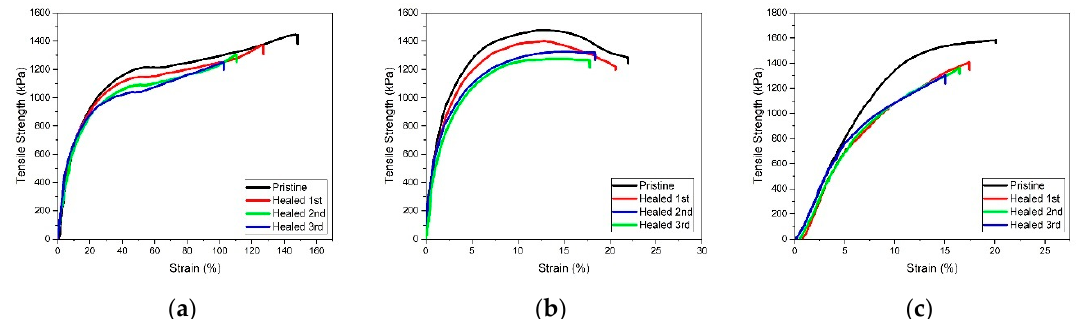
Figure 8. Tensile test results of PDMS -g- PUR composites and healed samples ( a ) PDMS -g- PUR/V10 ( b ) PDMS -g- PUR/V30 and ( c ) PDMS -g- PUR/V50. (The samples were healed at 50 °C for 2 h)